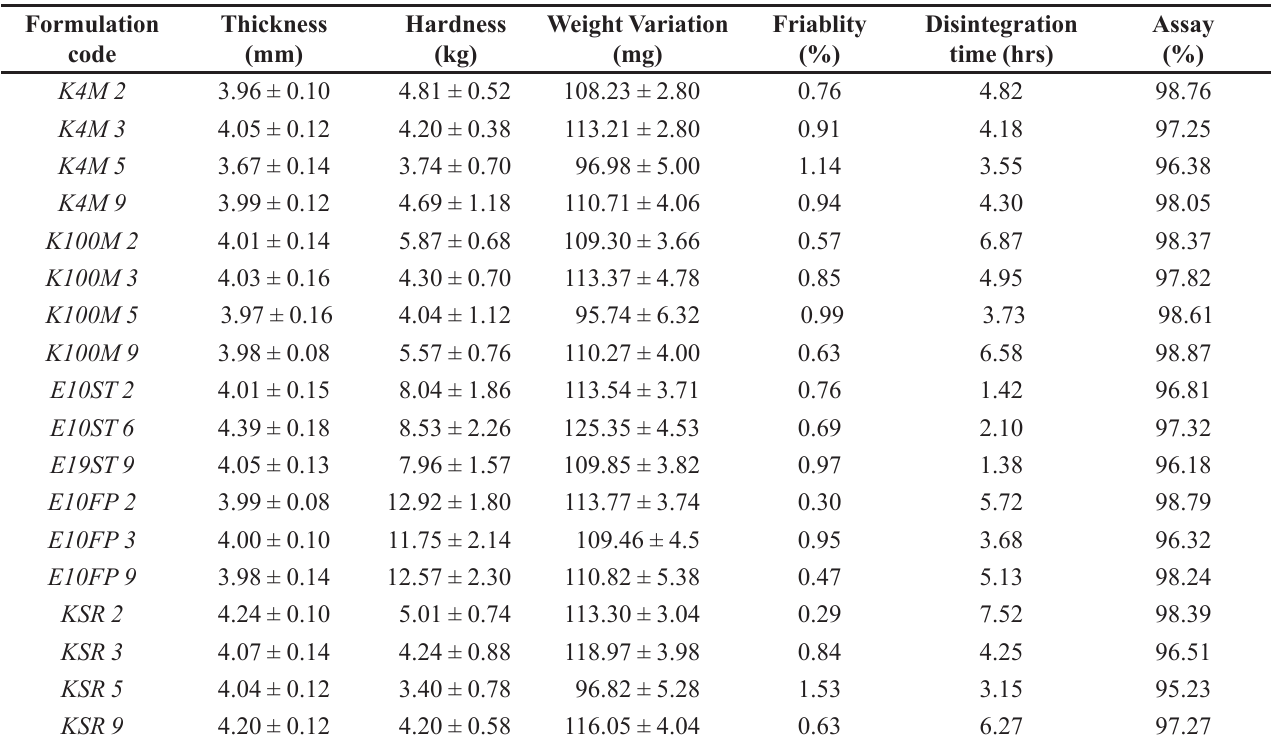
TABLE III - Physical Evaluation and assay of tizanidine matrix Formulation